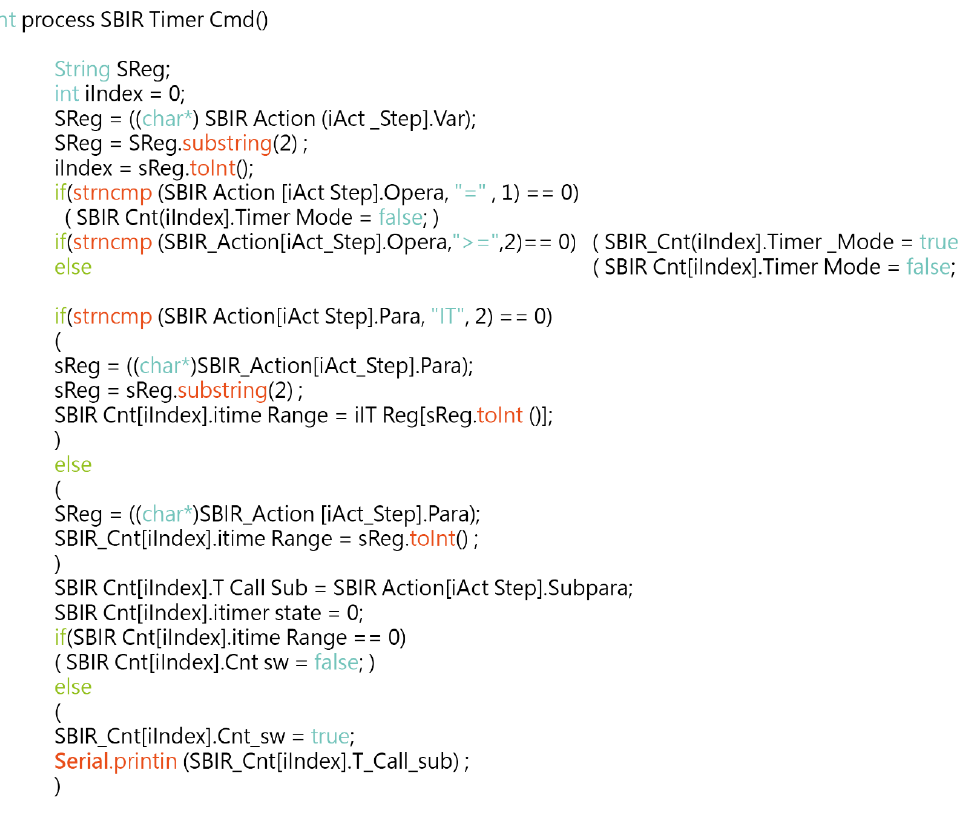
Figure 8. The source code of the timer function.